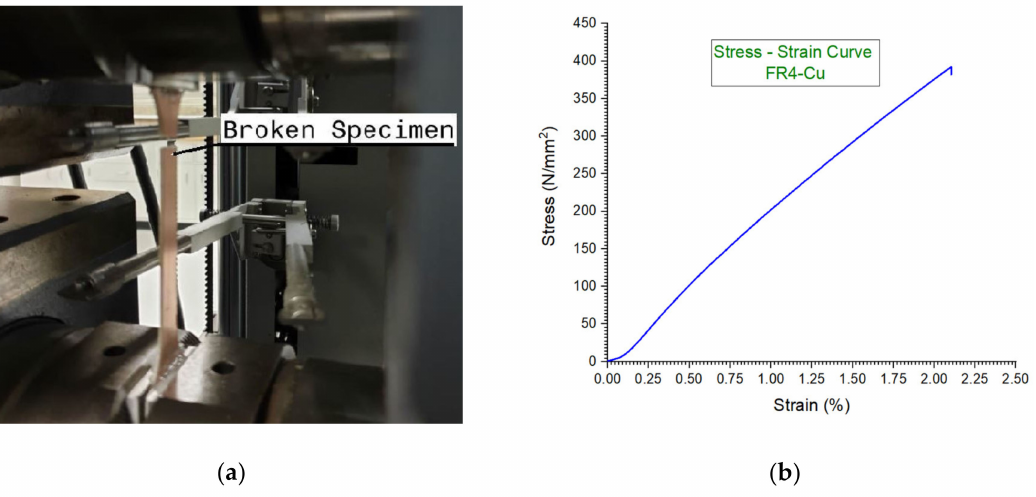
Figure 3. Experimental estimation of E PCB . ( a ) Specimen under test (sample 3 of Group 2), ( b ) stress–strain curve of the specimen depicted in ( a